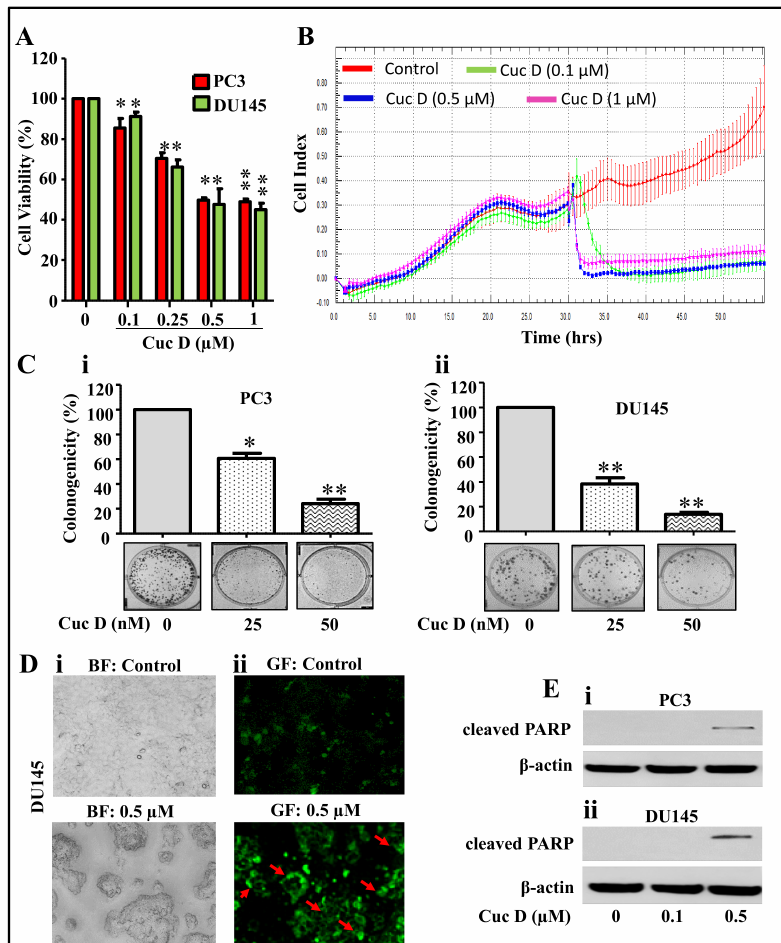
Figure 1. Effect of Cuc D on cell proliferation, clonogenic potential and apoptosis induction in PrCa cells. ( A ) Effect of Cuc D on cell viability of PC3 and DU145. Briefly, cells were seeded in 96 well plate and after overnight incubation, treated with indicated concentrations of Cuc D for 48 h. Cell viability was assessed by MTT assay. The bar graph represents the percent viable cells compared to vehicle treated cells. Each concentration value is the mean ± SE of triplicate well of each group. Asterisk indicate statistical significance determined by Student’s t -test (* p < 0.05 and ** p < 0.01). ( B ) Effect of Cuc D on cell proliferation with respect to time was also confirmed by xCelligence assay. ( C ) Effect of Cuc D on colony formation of PrCa cells. In brief, 500 cells were seeded in each well of 6 well plates. After 3 days, cells were treated with indicated concertation of Cuc D for 7 days and then media was replaced with complete growth media and colonies were obtained which were further stained with hematoxylin. Photographs were taken by UVP-gel documentation system for PC3 ( Ci ) and DU145 ( Cii ). Bar graph represents number of colonies formed in each group of PC3 and DU145 cells. Experiments were repeated in triplicate with similar results. Asterisk indicate statistical significance determined by Student’s t -test (* p < 0.05 and ** p < 0.01). ( D ) Effect of Cuc D on apoptosis induction of DU145 cells as determined by Annexin V staining. In Brief, 0.5 × 10 6 cells were seeded in each well of 6 well culture plate. After 24 h, cells were treated with indicated concentrations of Cuc D and apoptosis induction was measured by Annexin V staining under fluorescent microscope. Representative images of control and Cuc D treated cells under bright field (BF) ( Di ) and green fluorescent (GF) ( Dii ). GF images (20 × ) represent the Annexin V stained cells as indicated by arrows. ( E ) Effect of Cuc D on protein levels of early apoptotic biomarker (cleaved PARP) in PC3 ( i ) and DU145 ( ii ) cells as determined by western blot analysis. β -actin was used as internal loading